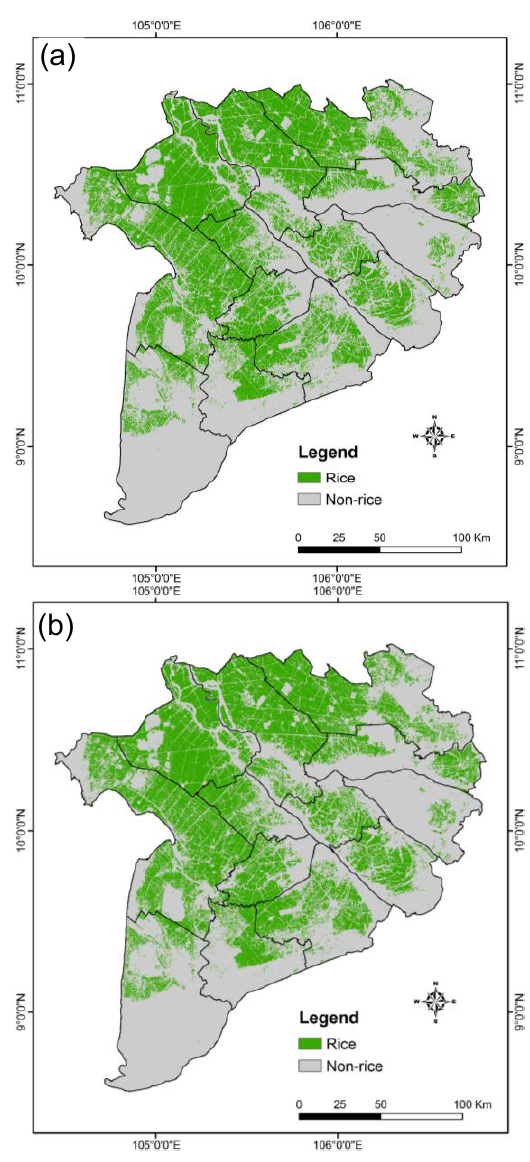
Figure 2. Spatial distributions of rice growing areas in 2015: (a) winter–spring crop, and (b) summer–autumn, autumn–winter